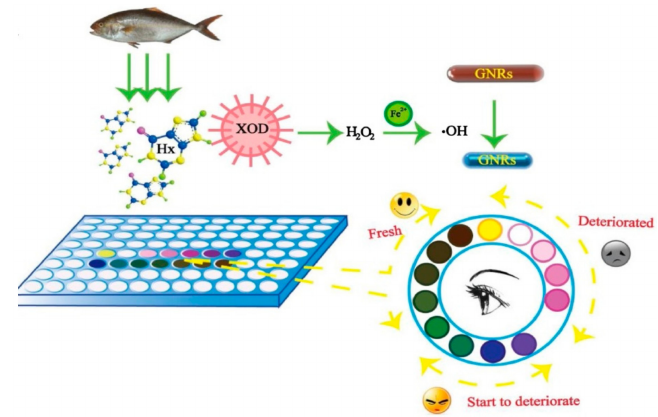
Figure 3. Example of colorimetric freshness sensor for fish via hypoxanthine detection (reproduced with permission from Reference